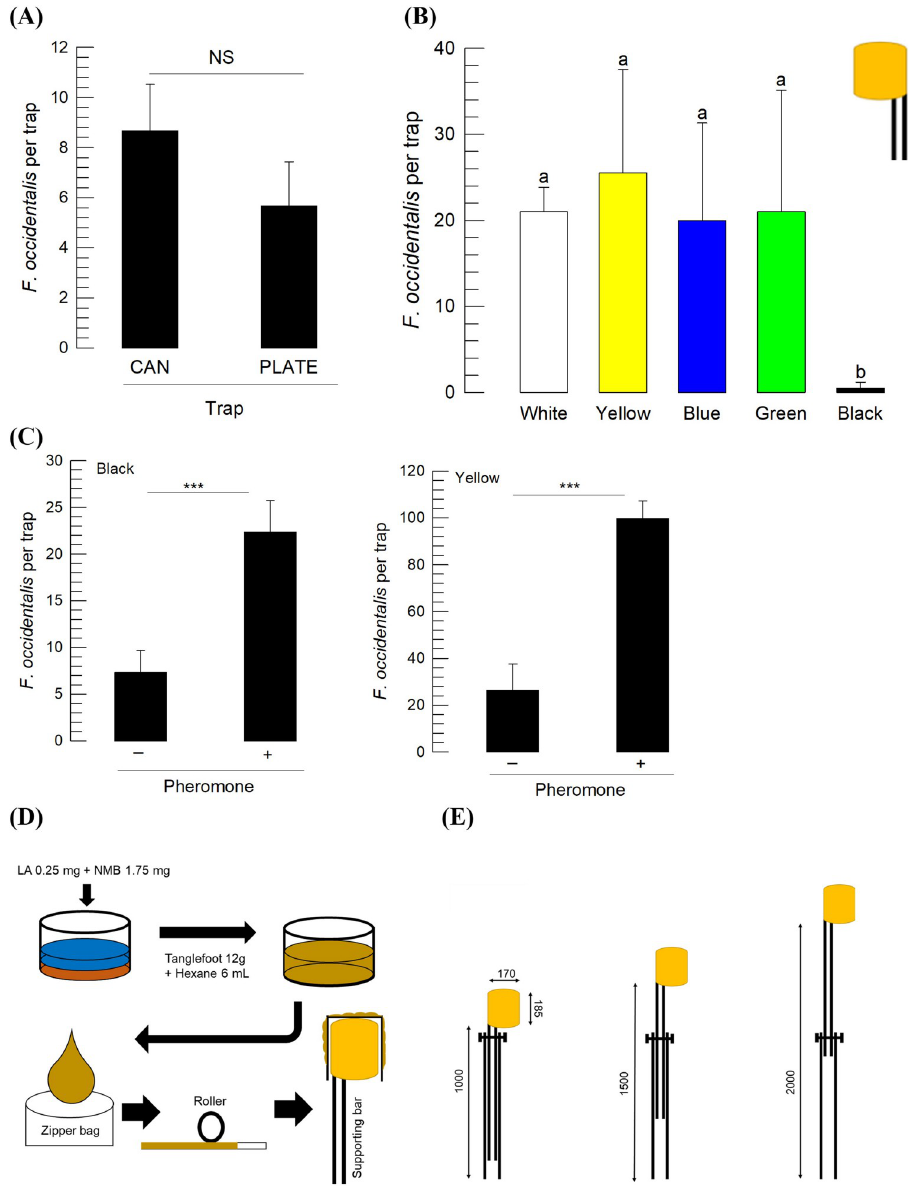
Fig 2. Development of a yellow CAN trap (CAN) to attract F . occidentalis using the aggregation pheromone. (A) Comparison of the attractiveness of the CAN trap without aggregation pheromone and a yellow sticky trap (PLATE). (B) Effect of CAN trap color on attracting thrips. (C) Effect of aggregation pheromone on attracting thrips using the CAN trap, in which the black CAN trap demonstrated a pheromone effect while the yellow CAN trap demonstrated both pheromone and color effects. Pheromone components were prepared by mixing lavandulyl acetate (LA) and neryl methylbutanoate (NMB) at a 1:7 mass ratio. Each experimental unit represented a trap and was replicated three times. (D) Preparation of a sticky bag for the CAN trap. (E) Dimensions (mm) of the CAN trap parts and adjustment of the CAN trap height. black background (Fig 2C). With a yellow background, the addition of the aggregation phero- mone increased the attractiveness of the CAN trap by almost five-fold compared to the trap without the pheromone. Based on the findings, a yellow CAN trap was constructed (Fig 2D).